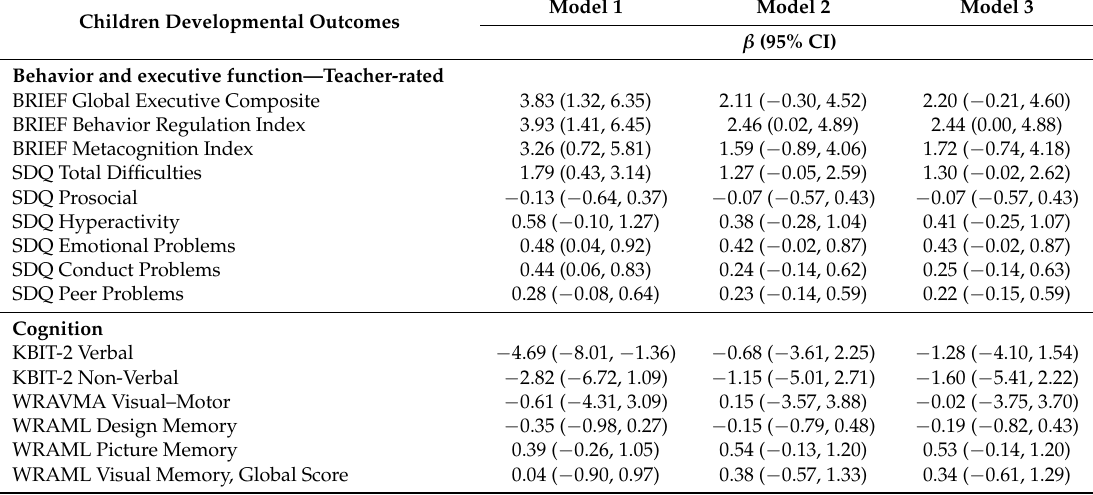
Table 2. Associations of maternal depressive symptoms in mid-pregnancy with offspring behavioral and cognitive outcomes in mid-childhood in the Project Viva cohort ( n =